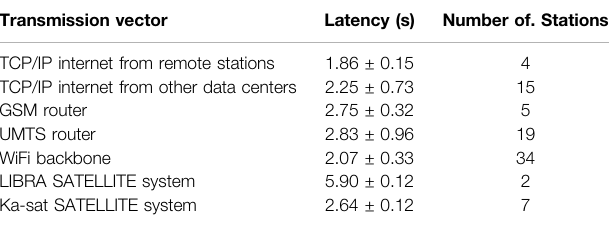
TABLE3| Transmissionvector,meanandstandarddeviationofdatalatency,and number of stations used for each type. Transmission vector Number of.